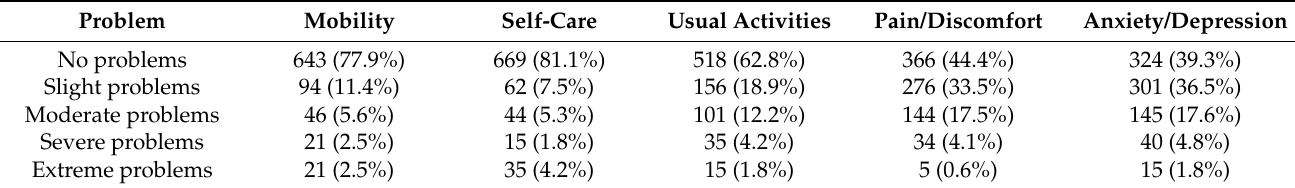
Table 3. Tabulations of caregivers EQ-5D response levels (Frequency,